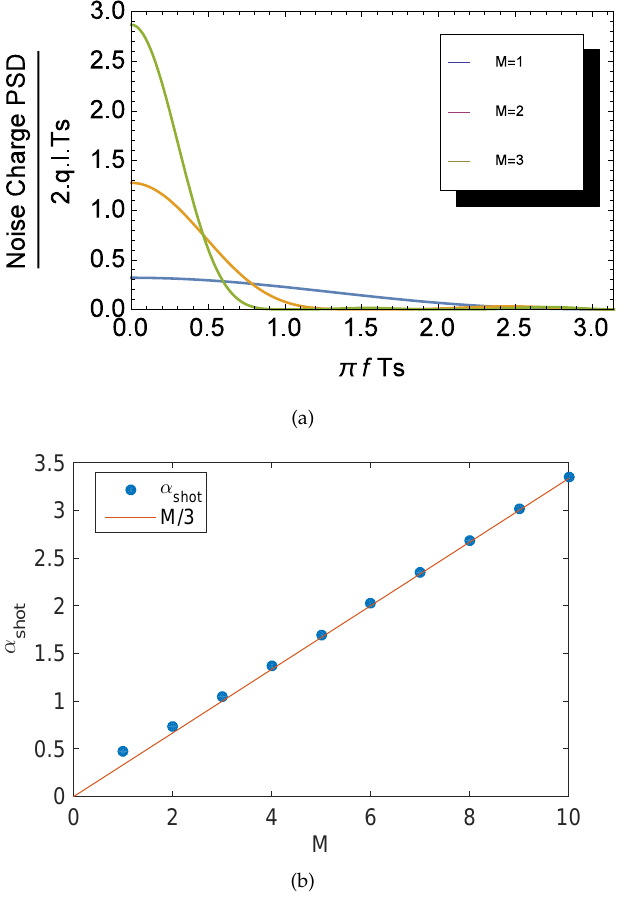
Figure 7. Input-referred shot noise PSD ( a ) and variance ( b ), normalized to 2 · q · I L · T S as a function of the correlated multiple sampling (CMS) order M